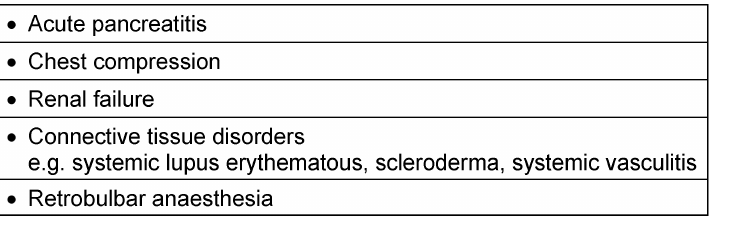
Table 2: Known diseases or events with Purtscher’s retinopathy